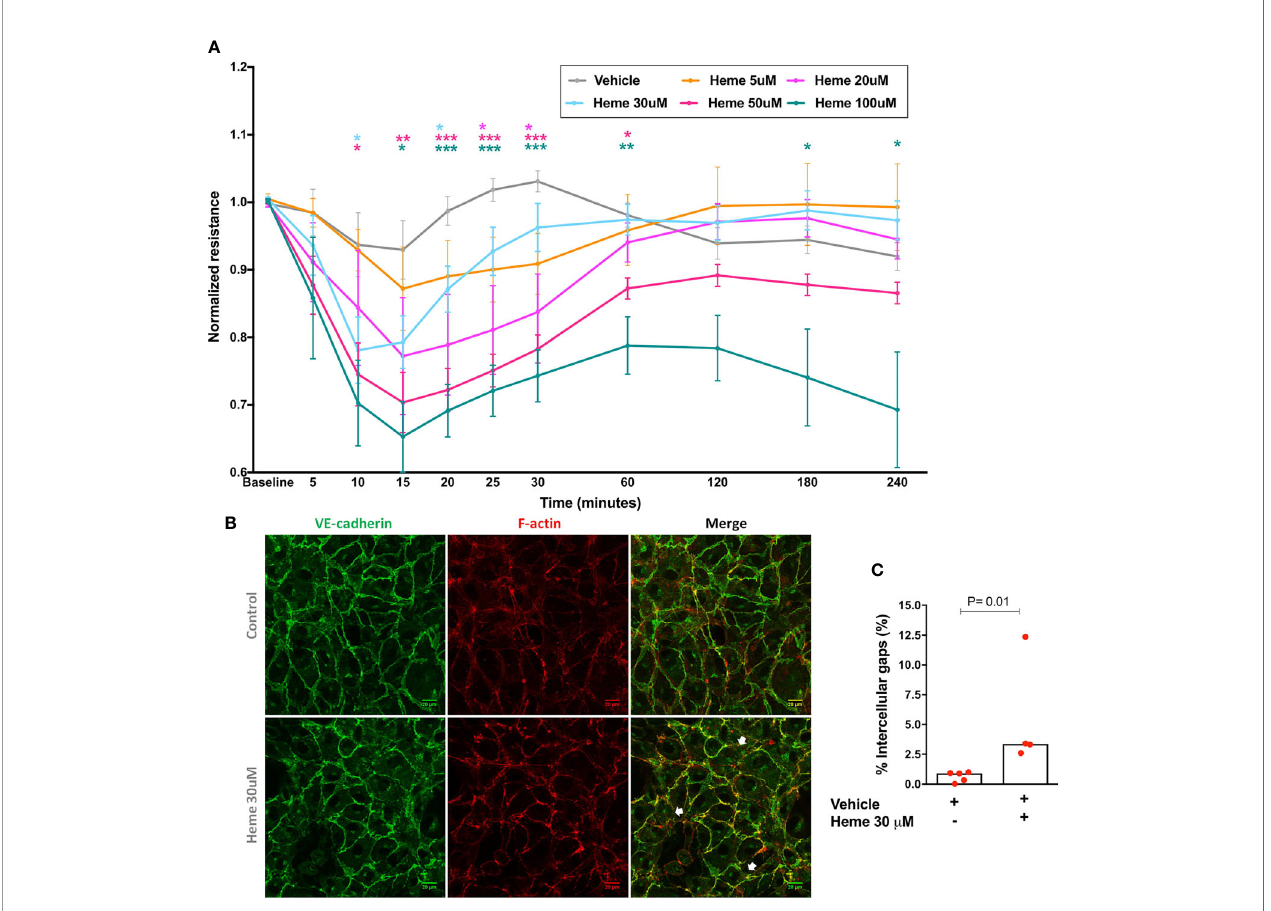
FIGURE 1 | Endothelial barrier integrity after heme stimulation. (A) Each line represents the mean ± SEM of the normalized resistance of HUVECs stimulated with heme in serum-free solutions measured by ECIS at 4,000 Hz. Differences between vehicle and heme-stimulated cells were compared using the Kruskal-Wallis test with the Dunn ’ s posttest. Statistical signi fi cant differences are indicated by colored asterisks on each timepoint. *P= 0.01 to 0.05; **P<0.01; ***P< 0.001; n = 5 to 15 independent experiments in at least three different days per heme concentration. (B) HUVECs were treated for 6 h with vehicle or heme 30 µM, and stained for the cell-cell junction marker VE-cadherin and for fi lamentous actin (F-actin). White arrows indicate intercellular gaps. (C) Semi-automated image processing identi fi ed intercellular gaps in the images that were quanti fi ed respect to the total area of the cell monolayer (n= 4 to 5 per group in two independent experiments). Mann- Whitney test; *P =0.01. Vehicle corresponds to the same solution used to dilute heme (NaOH 0.1 M), without heme. The fi nal NaOH concentration in each heme dilution varied from 0.01 to 0.2 µM for heme 5 µM to heme 100 µM. In vehicles, higher NaOH concentrations were used (0.06 to 0.2 µM in panel A , and 0.06 µM in panel B